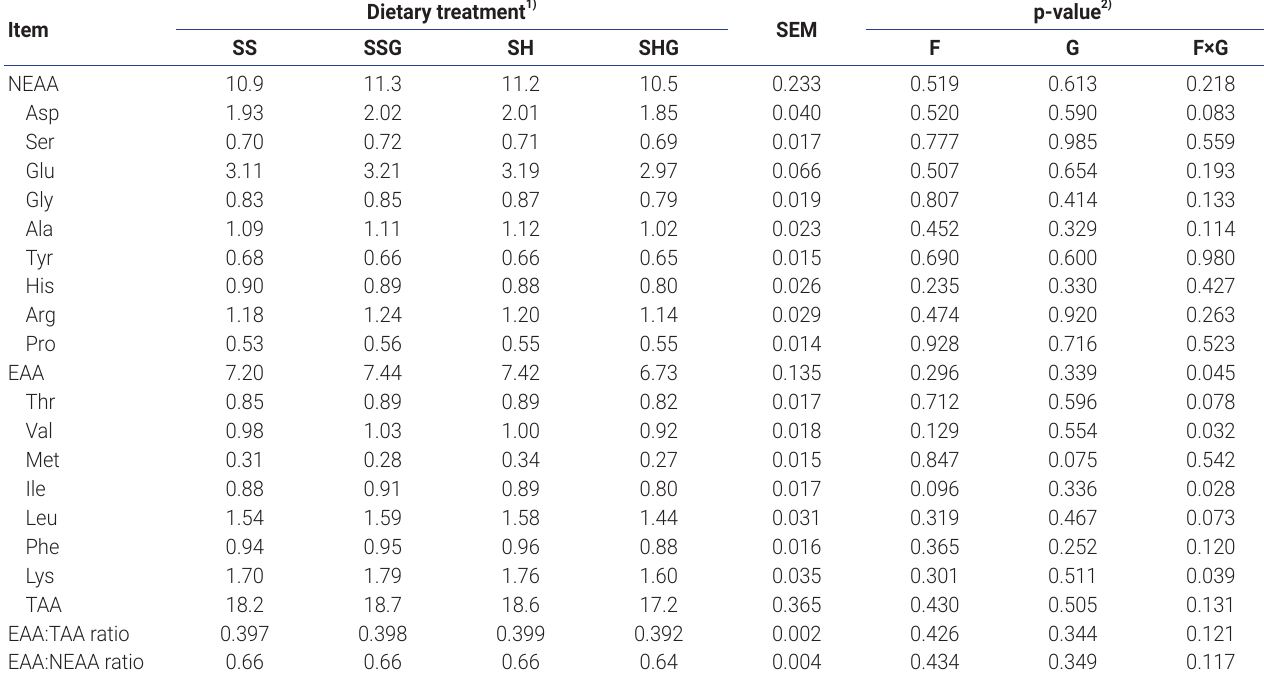
Table 5. Effect of grapeseeds (G) and sweet sorghum forage (F) on amino acid profiles of Small-tailed Han lamb meat (g/100 g Longissimus tho- racis tissue)